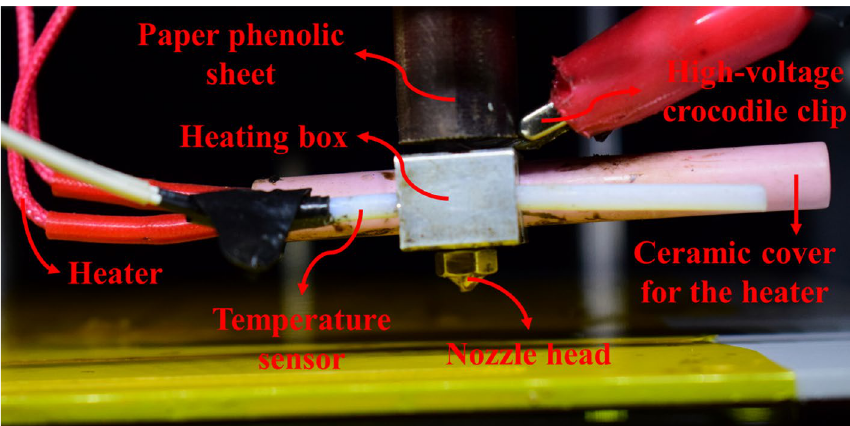
Figure 3. Print head and heating section of the modified FDM device and the configuration used to confine the high voltage to nozzle head and heating